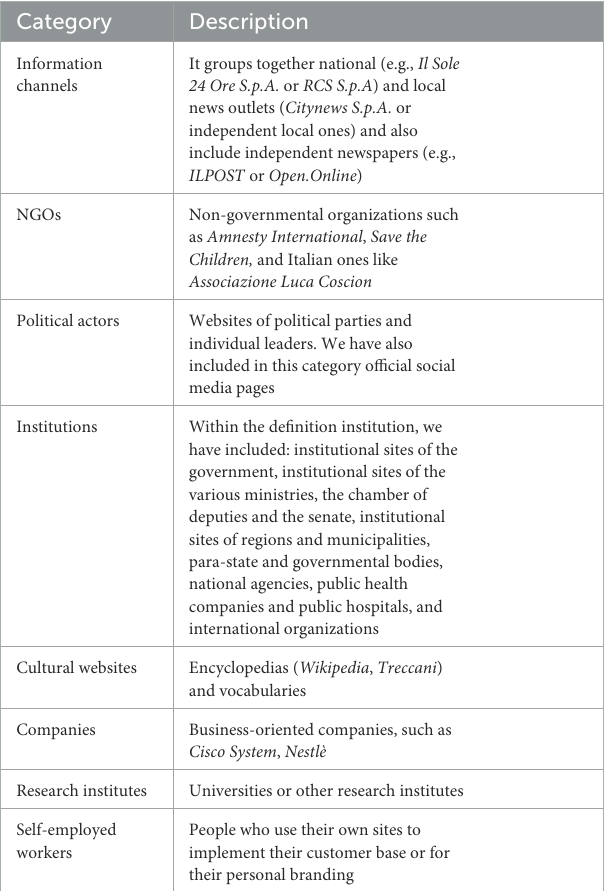
TABLE 1 Overview of the categories of actors behind the websites.